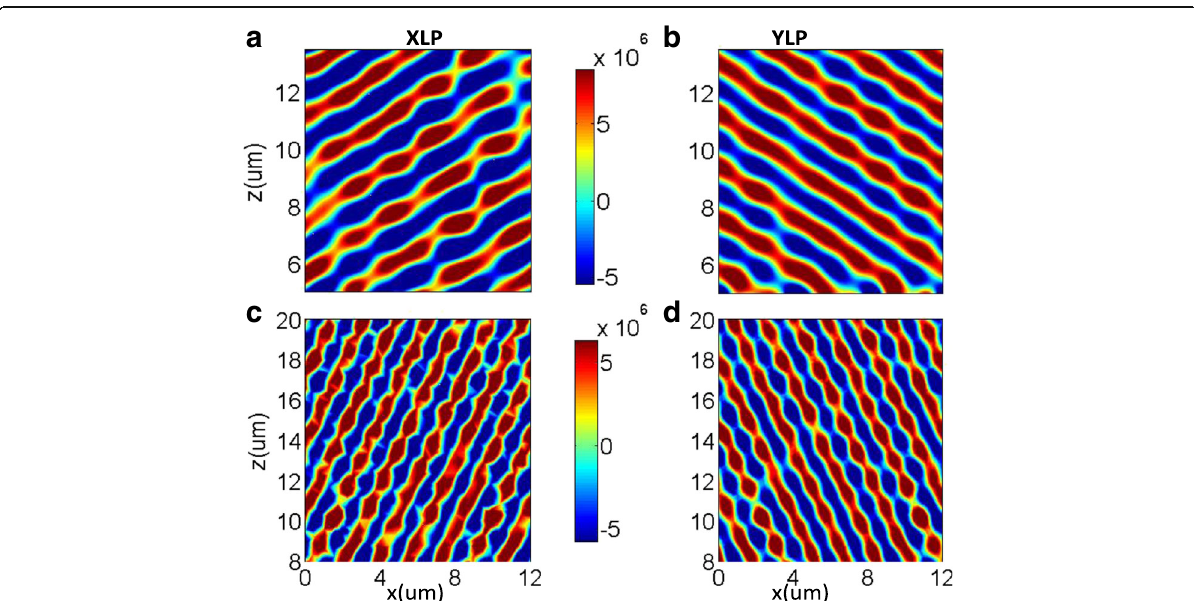
Fig. 4 The electric field distributions of extracted transmitted XLP ( left ) and YLP ( right ) under the normal incidence of 45 ° linear-polarization light to the metasurfaces of M 3 ( a , b ) and M 5 ( c , d ), respectively